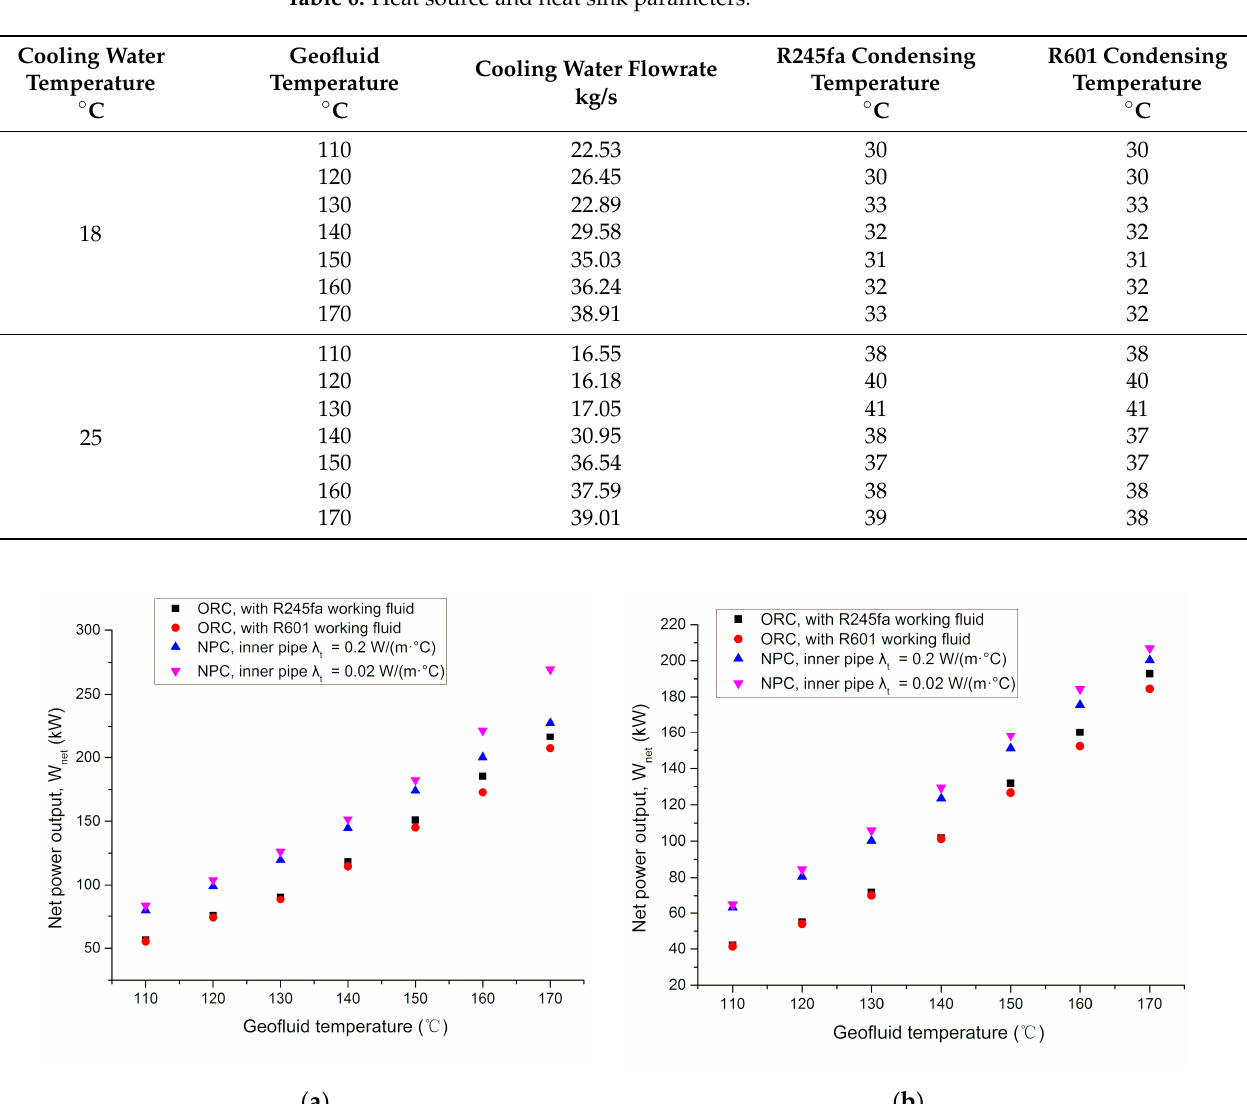
Table 6. Heat source and heat sink parameters.